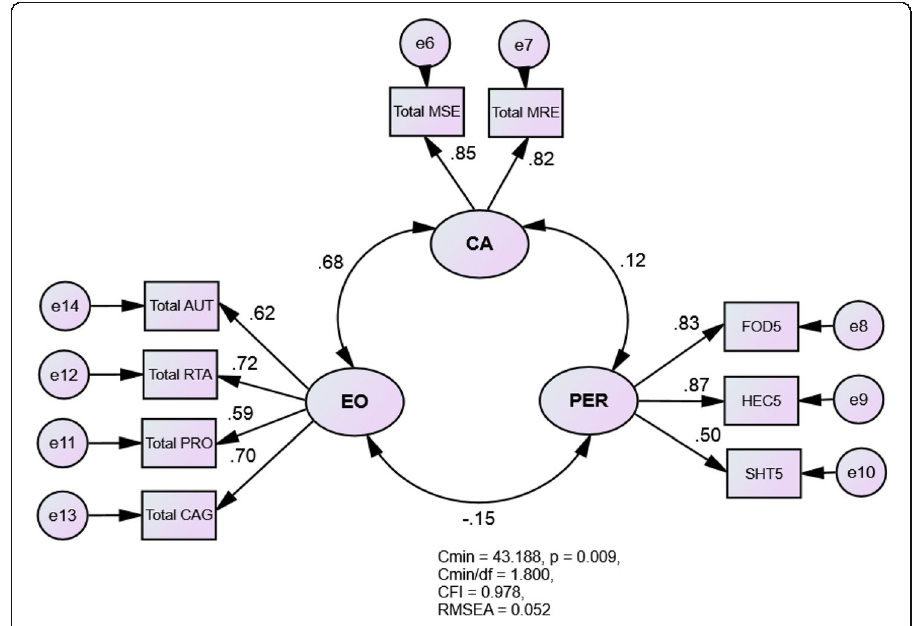
Fig. 2 Measurement model for personal wealth